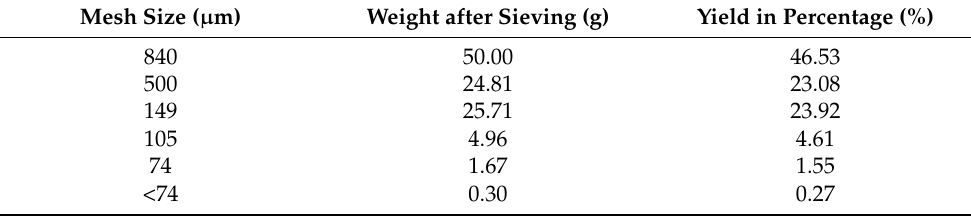
Table 1. Nicotina tabacum var. Virginia. Dried, ground, and sieved inflorescence from tobacco. Mesh Size ( µ